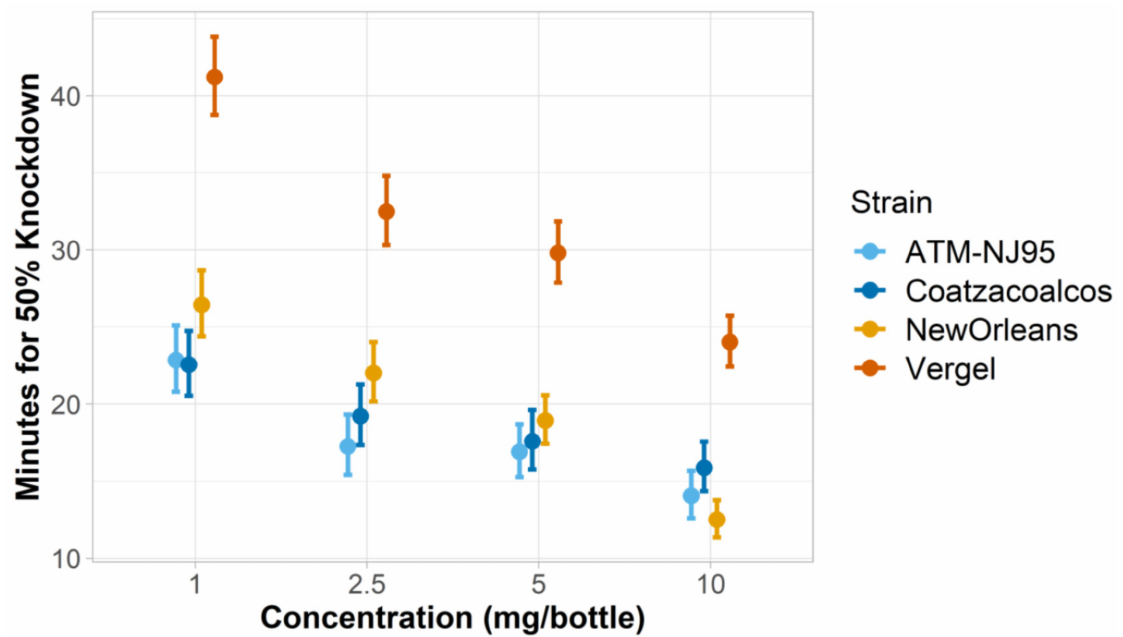
Figure 2. Knockdown time 50% (KT50) calculated for each concentration of nootkatone (mg/bottle) for Aedes spp. Whiskers denote the 95% confidence intervals. A. aegypti strains = New Orleans and Vergel and A. albopictus strains = ATM-NJ95 and